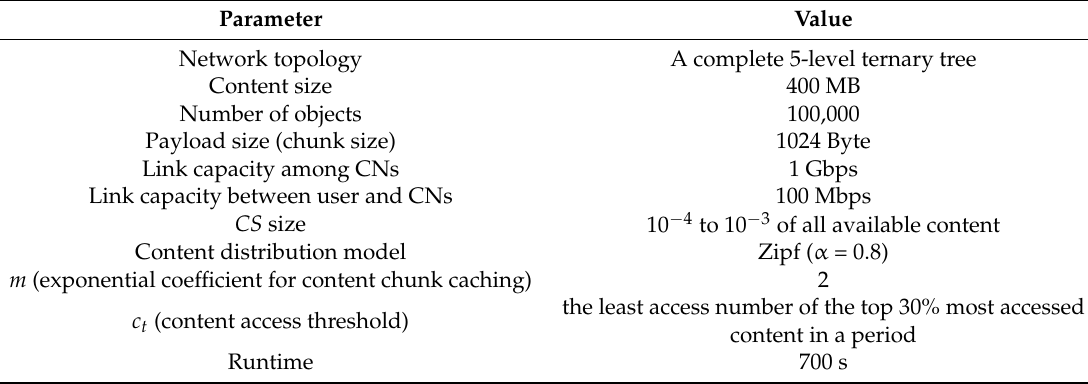
Table 1. The key simulation